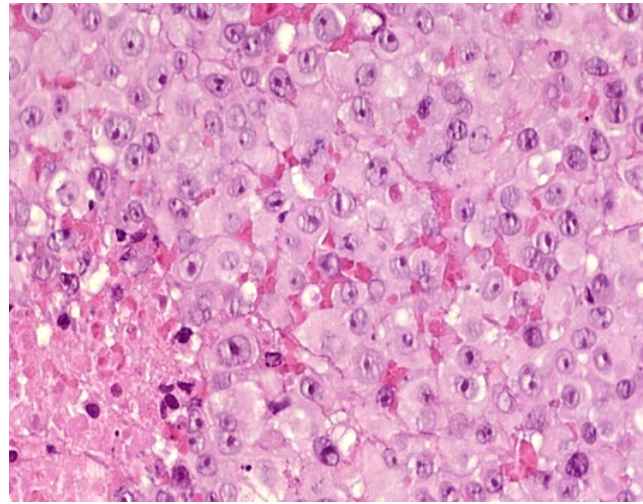
Figure 6. 40× Rhaboid tumor. Very atypical large cells. Outcome